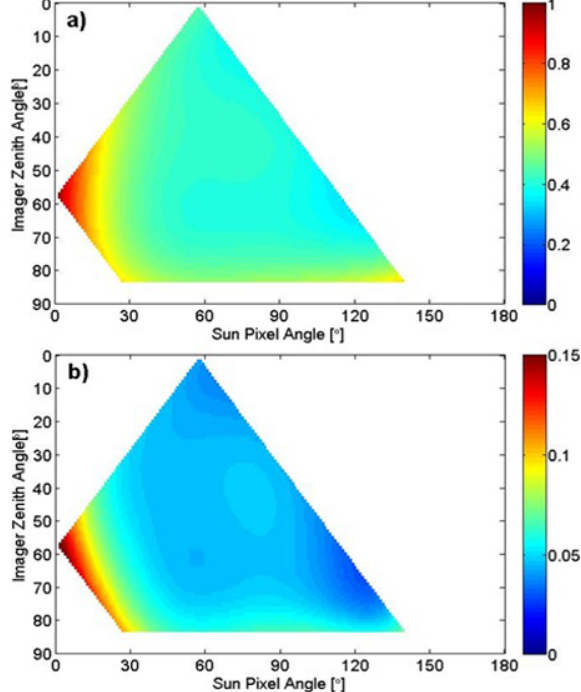
Fig. 3. (a) CSL’s RBR generated on 27 January at SZA = 56 ◦ (b) Standard Deviation of RBR (color bar, unitless) between CSLs gen- erated on 27 January, 12 February, 27 April and 4 May 2011 at SZA = 56 ◦ .